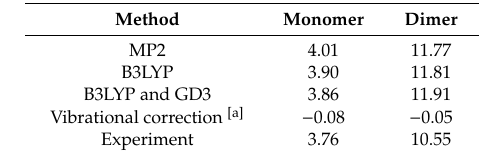
Table 3. The calculated 1 H–NMR chemical-shift di ff erences δ OH – δ Me (ppm) of the acetic acid monomer and dimer. The computations were performed on the structures optimized with the Aug-cc-pVQZ basis set using the same method as the subsequent NMR calculation.